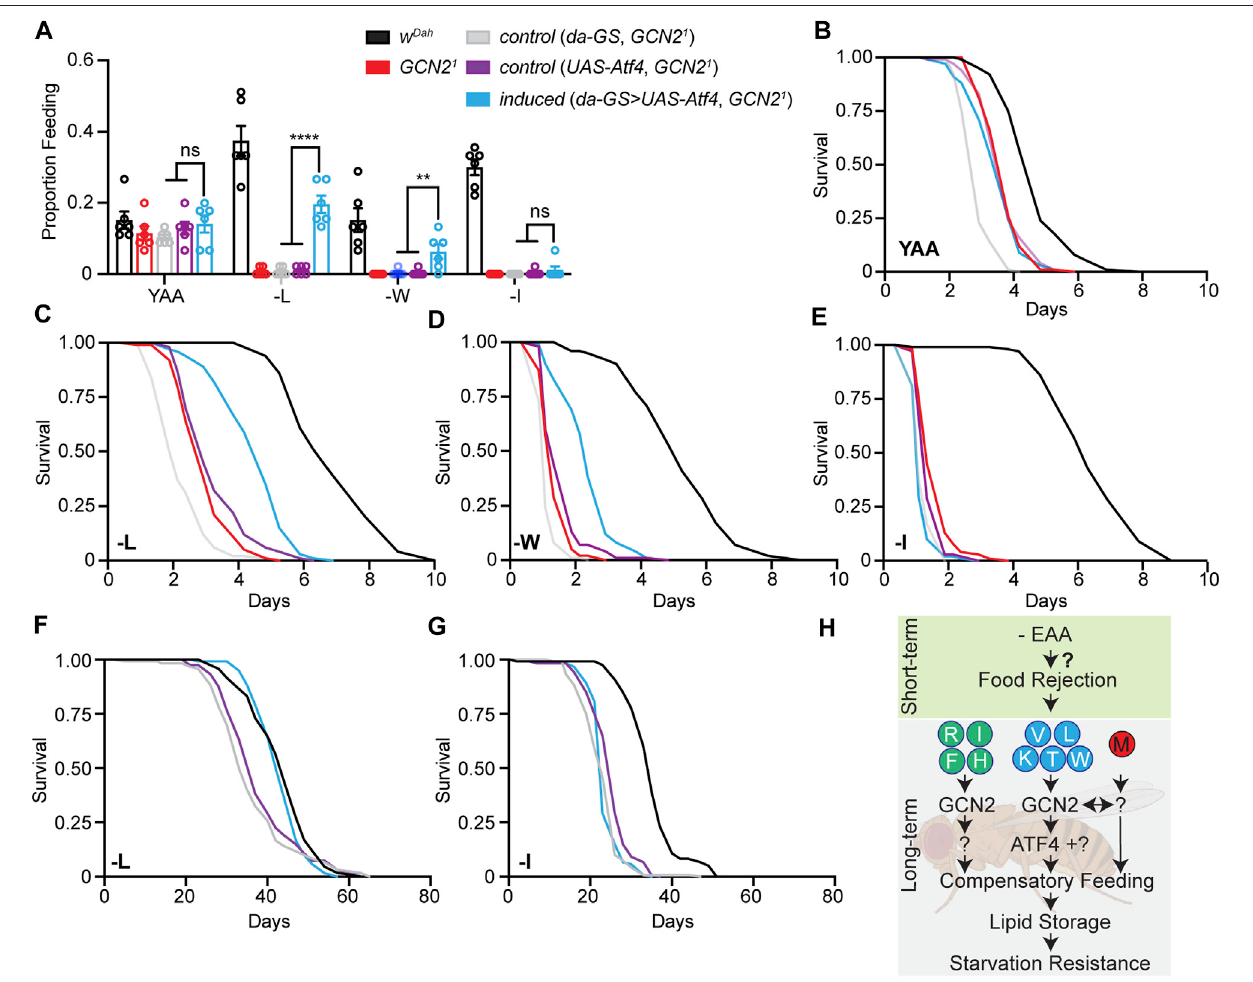
FIGURE 7 | Over-expression of Atf4 partially rescued feeding behaviour of Gcn2 1 mutants in an amino acid dependent manner. (A) Feeding rate of fl ies fed L, W, andIdepriveddietsfor7 days.Ubiquitousadult-speci fi coverexpressionof Atf4 in Gcn2 1 mutantfemalesrescuedfeedingbehaviourunderLandWbutnotIdeprivation. n =6vialswith fi ve fl iespervial.Dataarepresentasmean±s.e.m.One-wayANOVAfollowedbyDunnett ’ smultiplecomparisonstest; p valueswereadjustedformultiple comparisons. (B – E) Survival under full starvation of fl ies preconditioned on Yaa, -L, -W, and -I diets for 7 days. Ubiquitous adult-speci fi c over-expression of Atf4 in Gcn2 1 mutant females partially rescued starvation sensitivity on -L and -W but not on -I diets: -L: p da-GS = 1.8 × 10 − 34 , p UAS-Atf4 = 4.4 × 10 − 13 ; -W: p da-GS = 2.1 × 10 − 33 , p UAS-Atf4 =7.6×10 − 13 ;-I: p da-GS =7.3×10 − 12 , p UAS-Atf4 =0.22, -I, p da-GS =0.32, p UAS-Atf4 =4.9×10 − 7 .log-rank test. n =100 fl ies perdietand genotype. (F,G) Survival of fl ies under deprivation of -L (F) and -I (G) . Ubiquitous adult-speci fi c over-expression of Atf4 in Gcn2 1 mutant females rescued survival under L but not under I deprivation. -L: p da-GS = 7.2 × 10 − 6 , p UAS-Atf4 = 0.001. ATF4 overexpression in (A – G) was induced by 50 μ M RU486 using the da-GS driver. (H) Schematic overview about the role of GCN2 under individual EAA deprivation. (H) was created with BioRender.com.